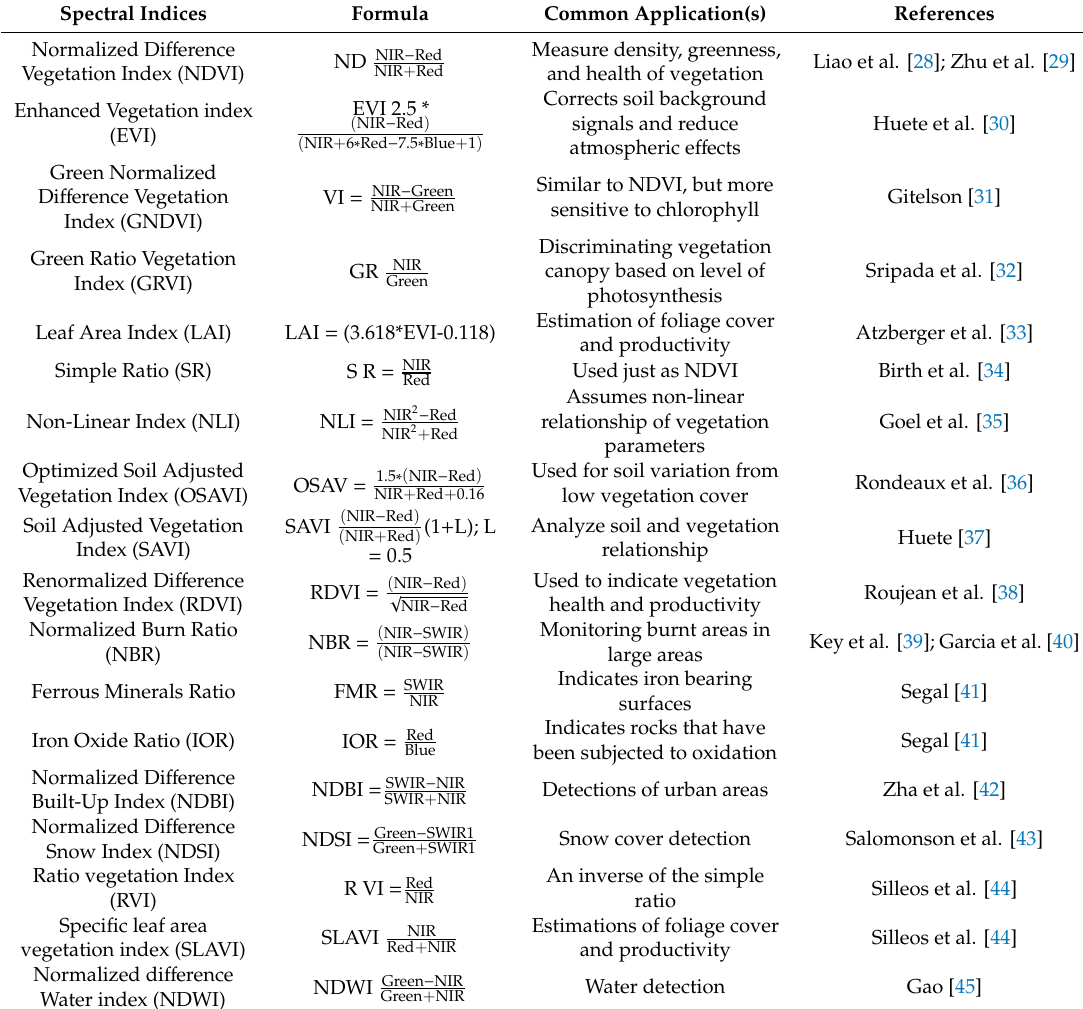
Table 2. Selected spectral indices used for developing DT